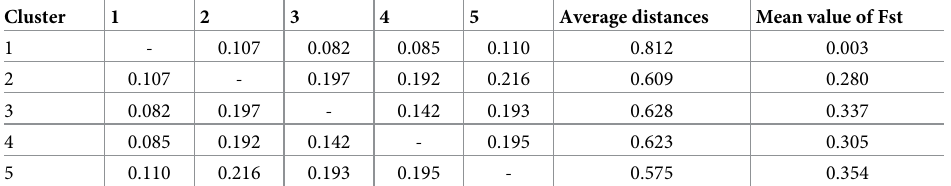
Table 5. Allele-freq. divergence (Net nucleotide distance), computed using point estimates of P through Structure